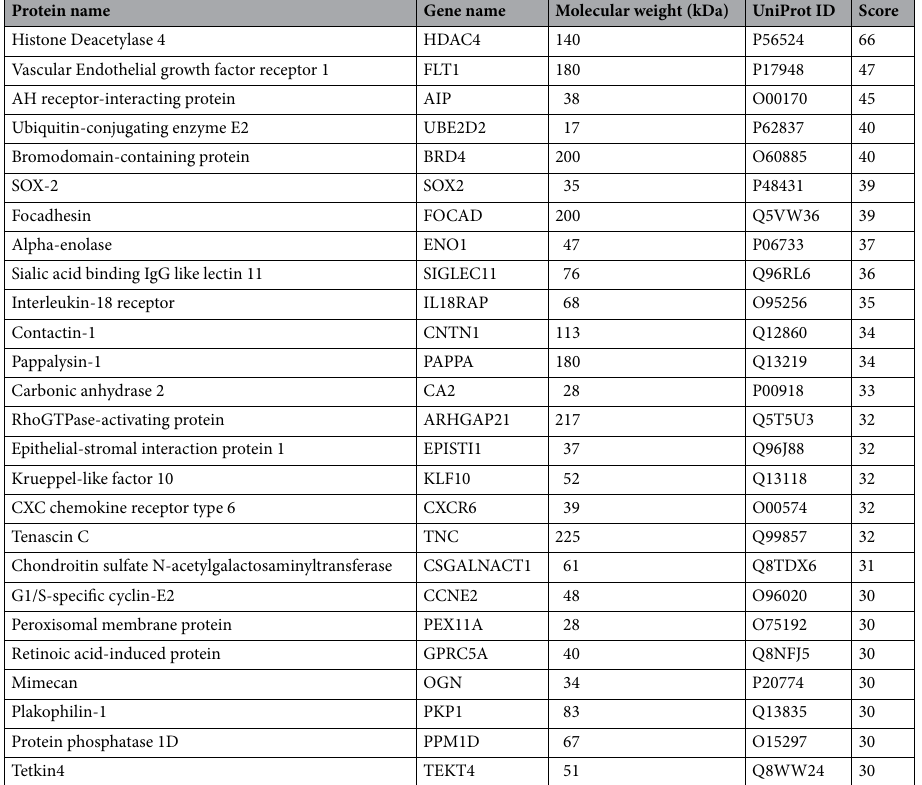
Table 2. β-Catenin interacting partners from control corneal epithelium using Co-IP/MS